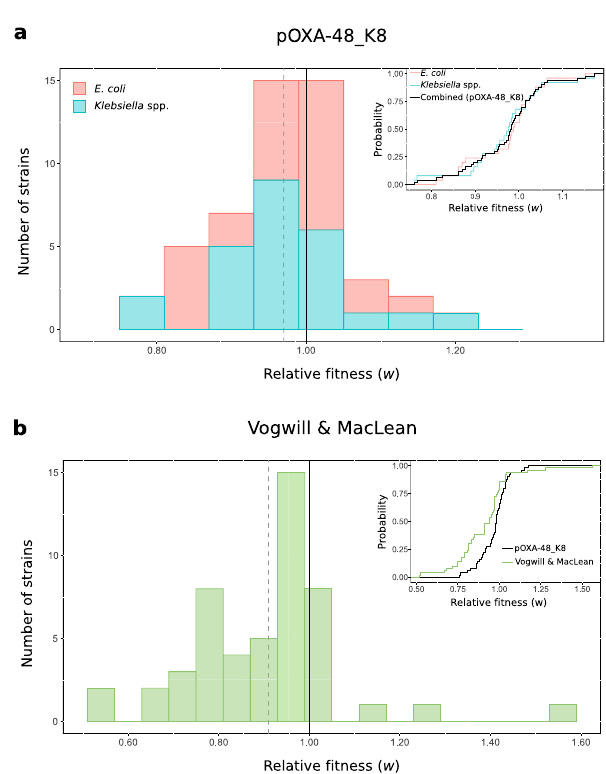
Fig. 3 Distribution of plasmid fi tness effects. Comparison between plasmid fi tness effects obtained in this study and those from previous studies. a Distribution of pOXA-48_K8 fi tness effects in the ecologically compatible collection of enterobacteria isolates. Bars indicate the number of E. coli (red) and Klebsiella spp. (blue) strains in each relative fi tness category. The grey dotted line indicates the mean relative fi tness of the population. Note that relative fi tness values are normally distributed ( w = 0.971, var = 0.0072, one-sided Shapiro – Wilk normality test, P = 0.14). The inset shows the cumulative distribution function (CDF) of the relative fi tness of pOXA-48_K8-carrying E. coli (red), Klebsiella spp. (blue) clones, both individually and combined (black). b Distribution of plasmids fi tness effects in bacterial hosts obtained in a previous meta-analysis 46 . Most of the included studies were based on associations between plasmids and bacterial strains from different ecological origins. Bars indicate the number of plasmid – bacterium associations in each relative fi tness category. The grey dotted line indicates the mean relative fi tness across studies. Relative fi tness values are not normally distributed ( w = 0.91, var = 0.029; one- sided Shapiro – Wilk normality test, P = 0.0006). The inset shows the CDF of the relative fi tness of pOXA-48_K8-carrying enterobacteria analysed in our study (black) and the CDF of the relative fi tness of plasmid-carrying bacteria form Vogwill and MacLean meta-analysis (green). Source data are provided as a Source data fi